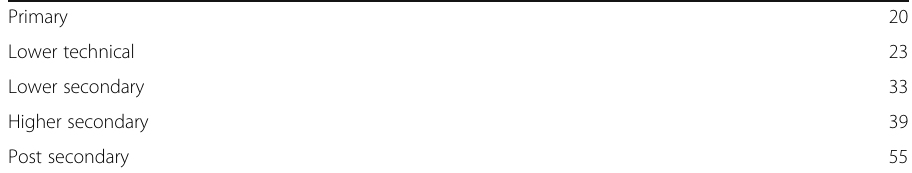
Table 12 Percent of pill users from 1963 to 1970, according to wife ’ s education, Belgium 1970 – 1971